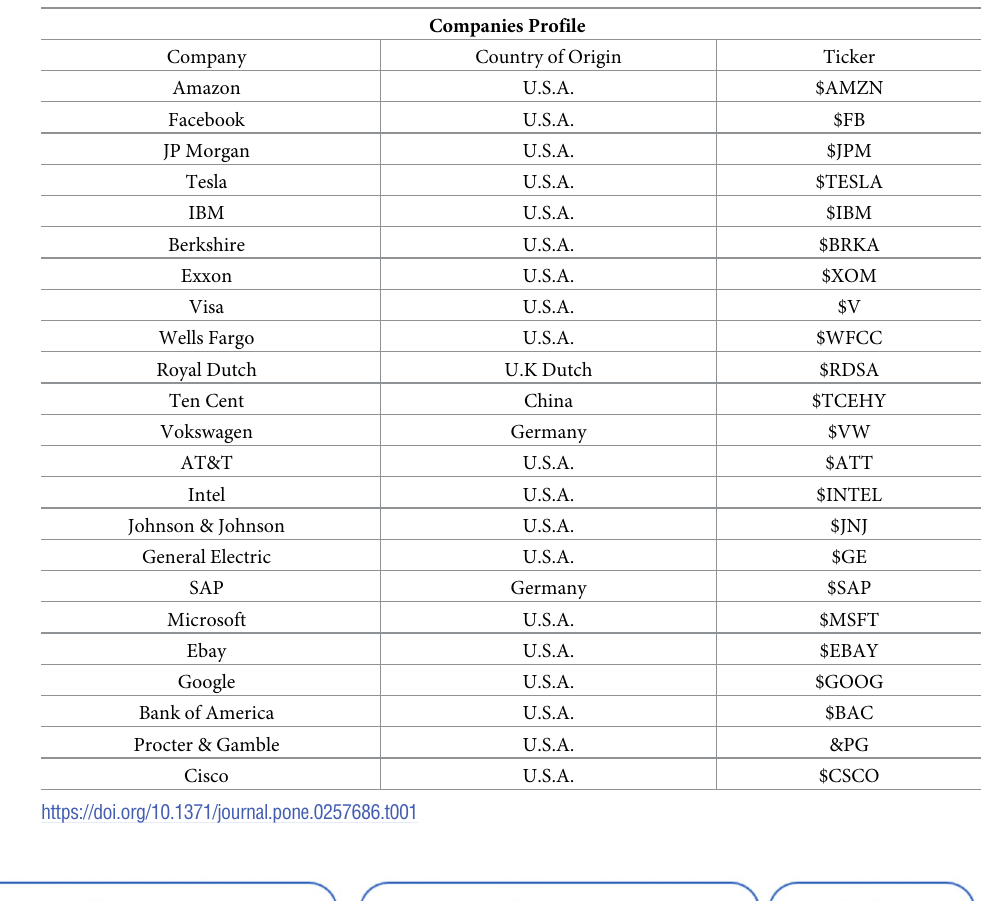
Table 1. Characteristics of the analyzed companies.